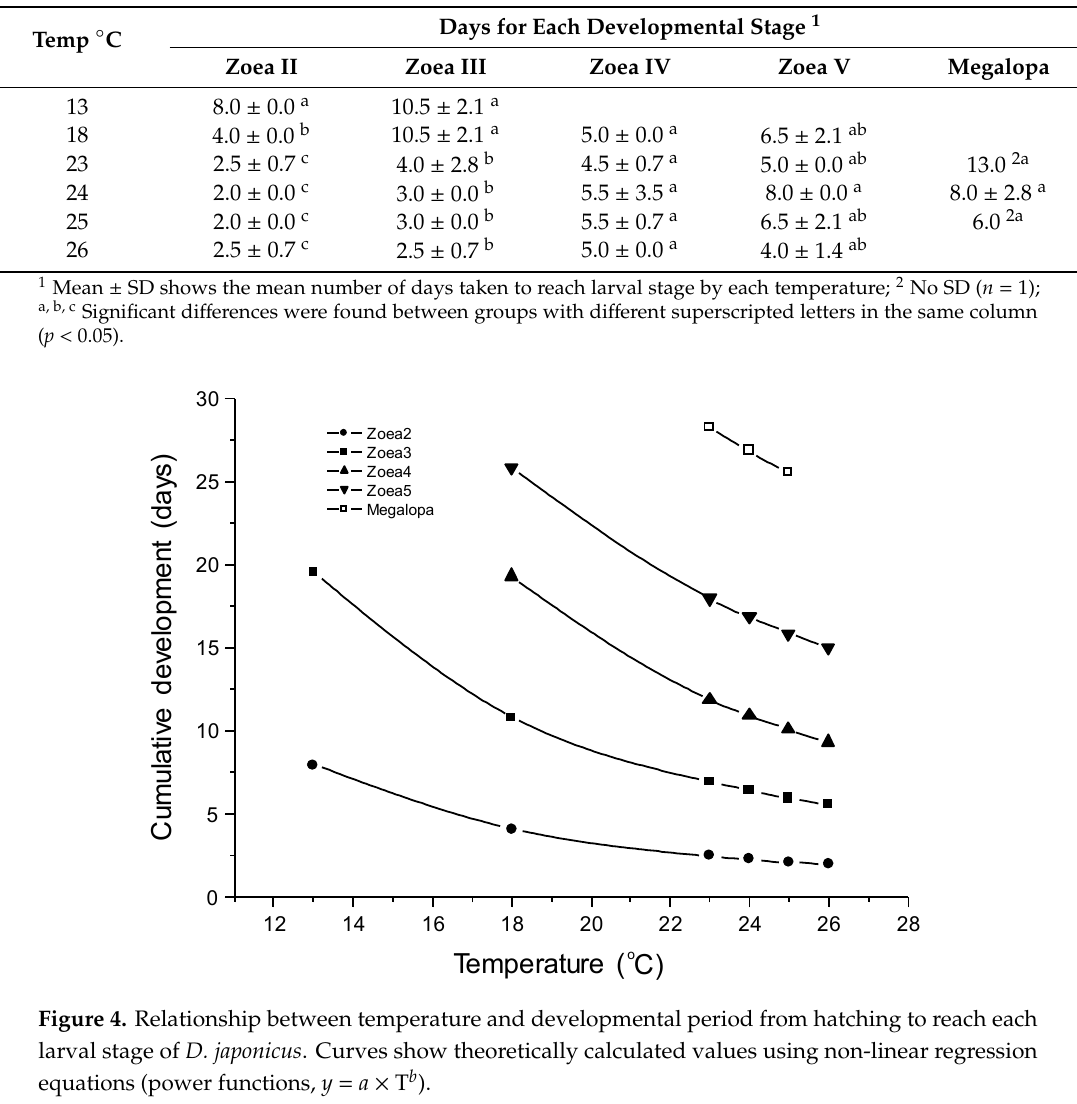
Table 2. Mean developmental period (days) from hatching required to reach each larval stage of D. japonicus reared under di ff erent temperature conditions.